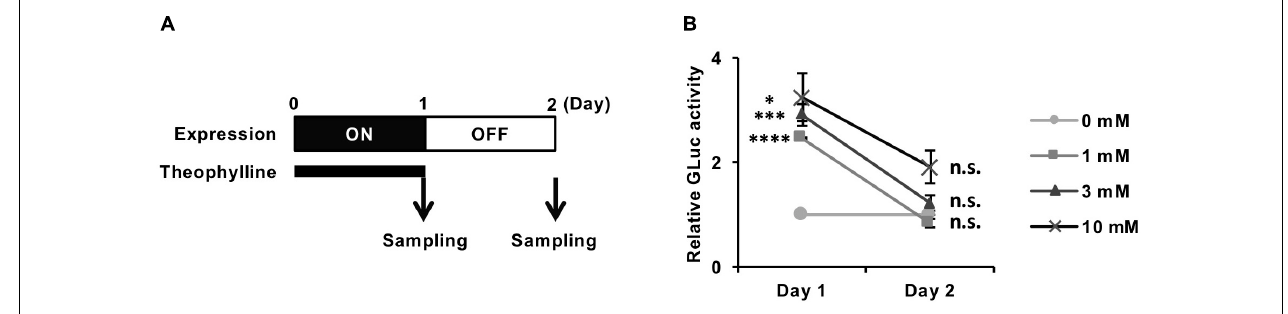
FIGURE 3 | Reversible control of transgene expression from REVec-GLuc-L2b9 by theophylline. (A) Time course of switching off the expression from REVec-GLuc-L2b9. Theophylline treatment was ceased on Day 1. The culture media were collected at the indicated time points, and luciferase activity was measured. (B) Relative luciferase activity at Days 1 and 2. Theophylline treatment at the indicated concentration was ceased on Day 1. Luciferase activities were normalized by the cell counts. Values are expressed as the mean ± S.E. ∗ P < 0.05; ∗∗∗ P < 0.005; ∗∗∗∗ P < 0.001; n.s., no significance (Student’s t -test; vs. 0 mM). At least three experiments were performed.